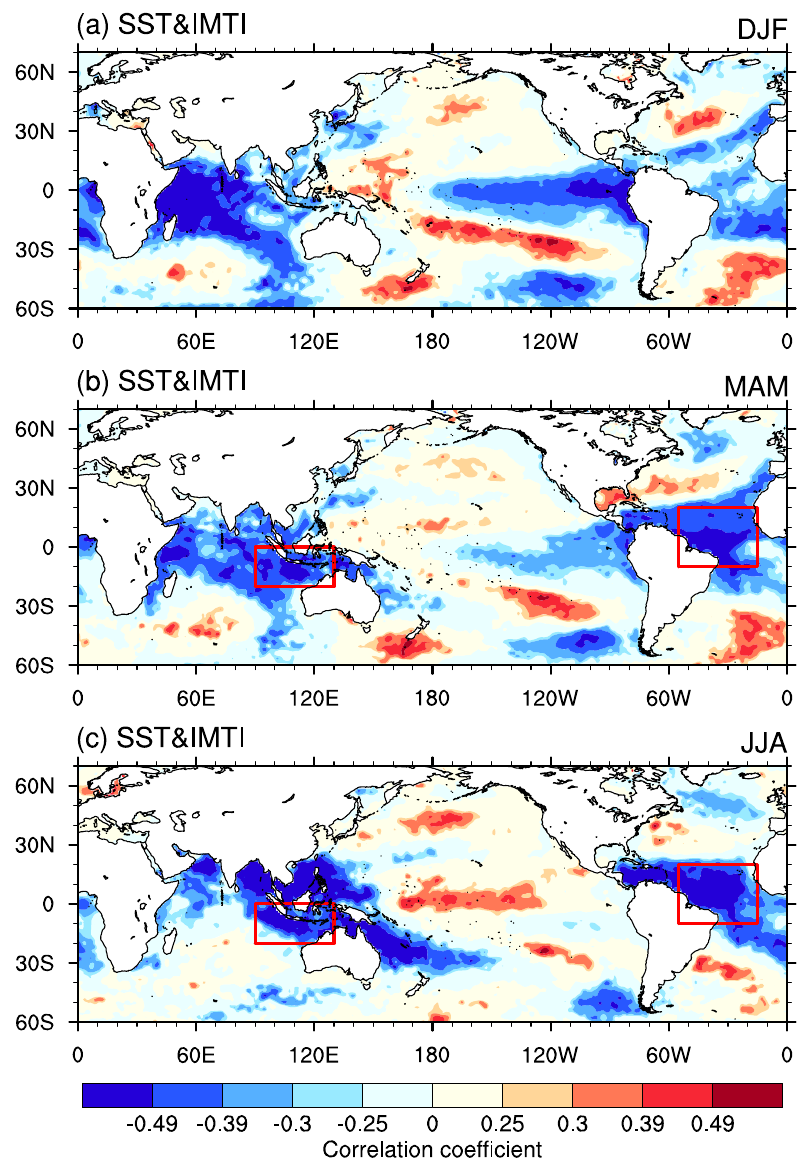
Fig.5|Indianmonsoontroughindex(IMTI)-predictorcorrelations. Correlation of sea surface temperature in a preceding winter, b preceding spring, and c simultaneous summer with the IMTI. The absolute values above 0.25, 0.30, 0.39,